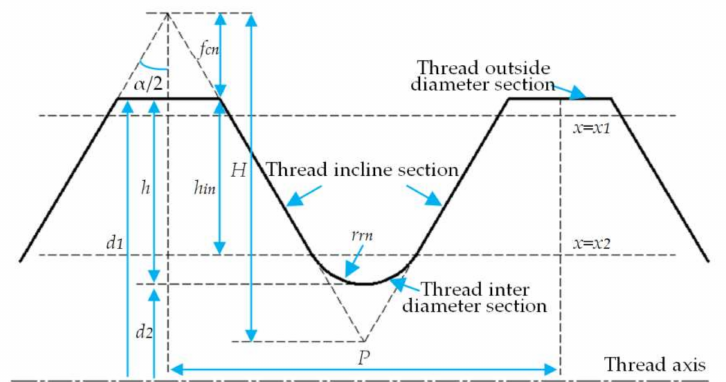
Figure 12. The contour curve of drill pipe